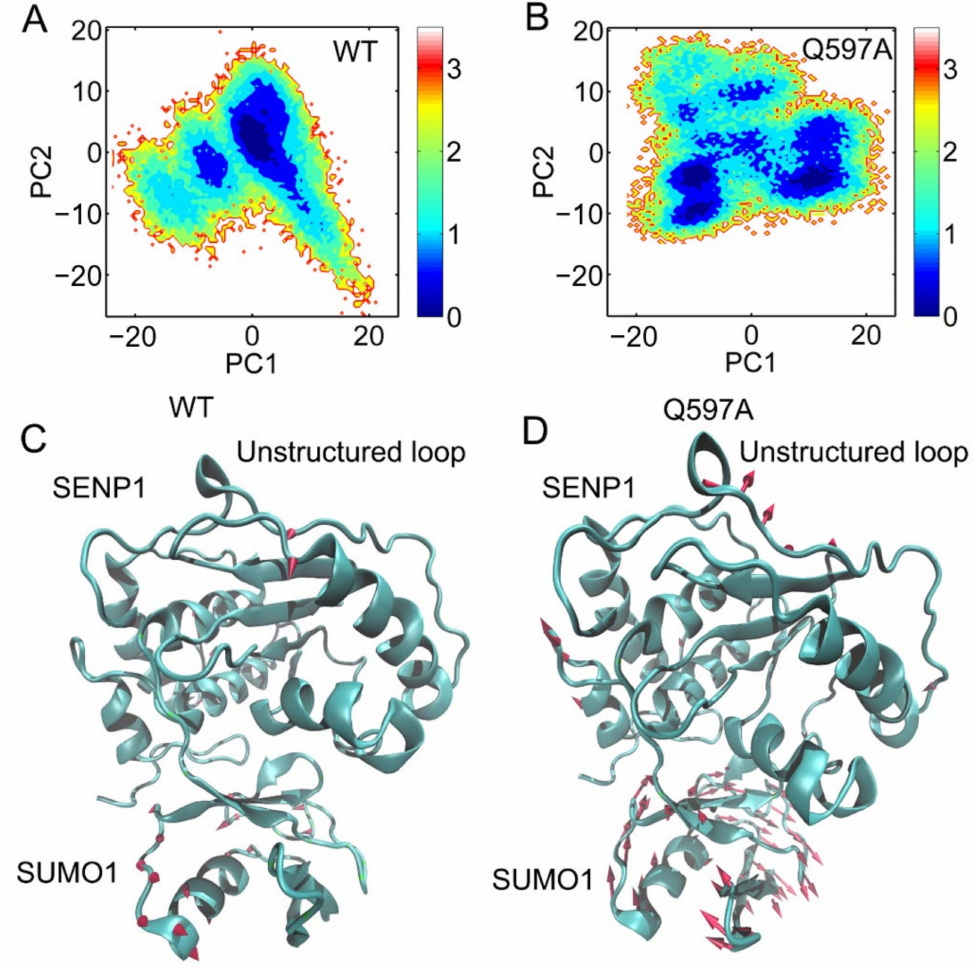
Figure 5. Projections of the first and second principal components (PC1 and PC2) from three replicate MD simulations for the WT ( A ) and Q597A mutant ( B ) systems. PC1 of the SENP1–SUMO1 complex for the WT ( C ) and Q597A mutant ( D ) systems. The sizes of the red arrows are proportional to the amplitude of